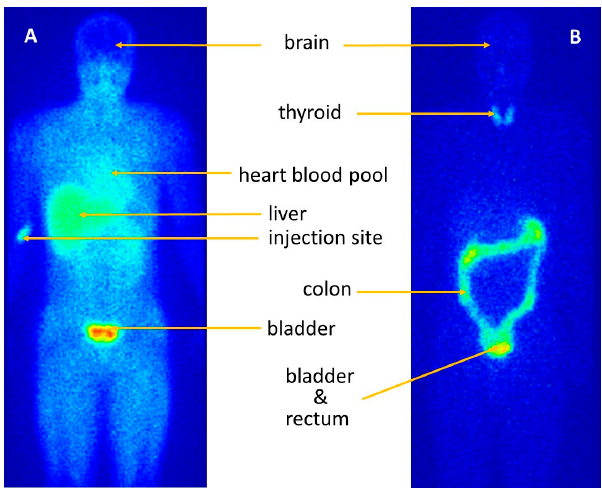
Figure 3. Planar anterior early ( A ) and late ( B ) images depicting radioactivity distribution following i.v. injection of [ 123 I]IAZA in an exercising volunteer. The left image ( A ), acquired 15–45 min after injection, shows extensive distribution of radioactivity throughout soft tissues, including viscera, skeletal muscle and heart/blood pool, but not brain. The right image ( B ), acquired 22 h after injection, shows that radioactivity has effectively been cleared from the body except for thyroid (estimated at 0.5% of the dose) and large bowel (estimated at 5% of the dose). Images reflect identical total counts/image, which necessitated longer imaging time for the 22 h image because by then most of the radioactivity had decayed (~2 × physical T 1/2 ) and/or been excreted.